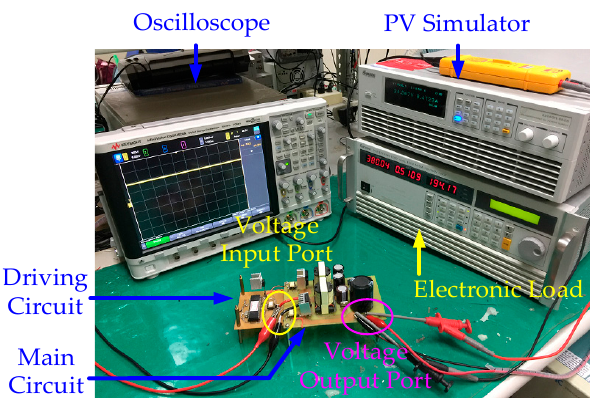
Figure 8. Photo of the experimental setup.